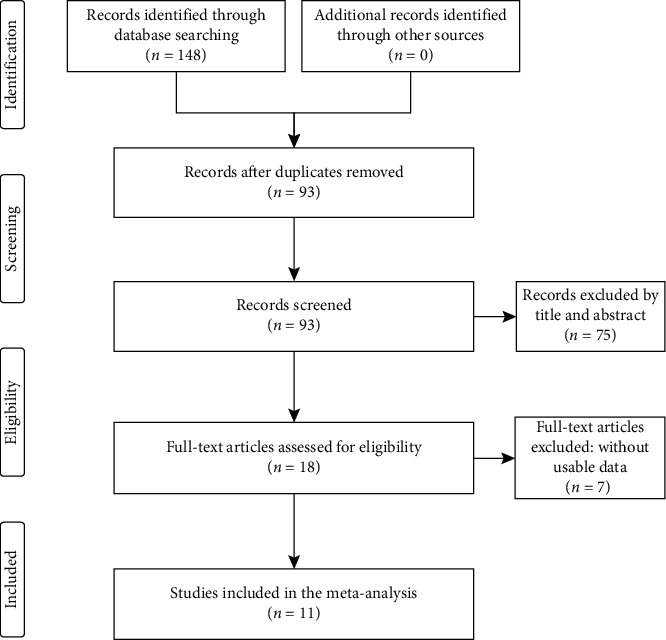
Flow diagram of the study search and selection.